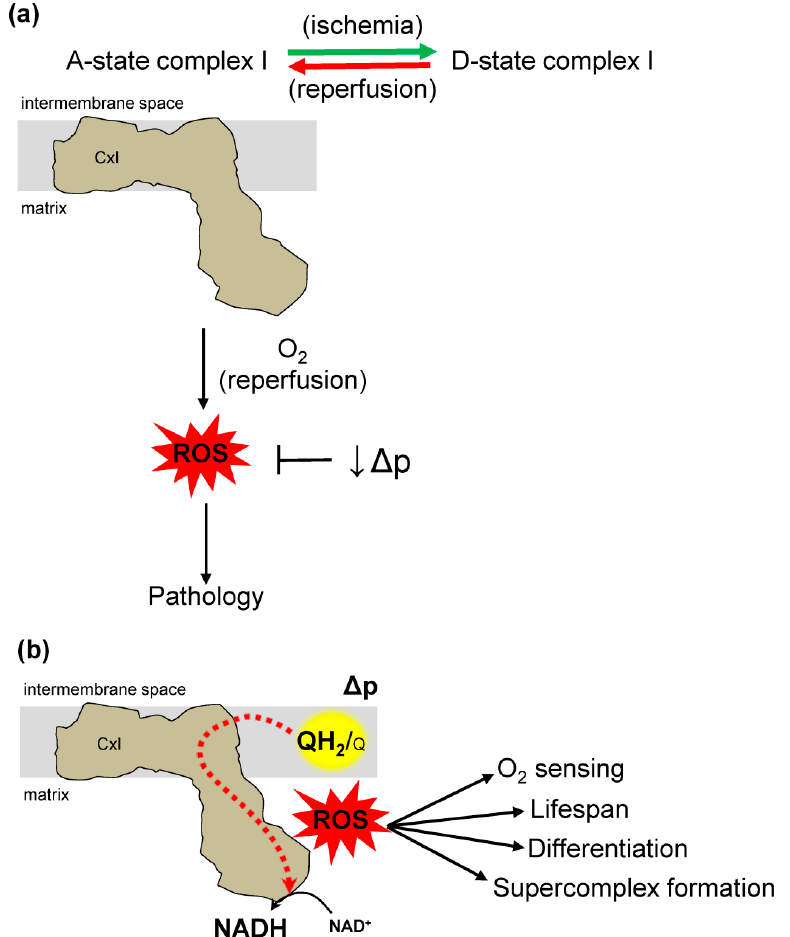
Figure 4. Dual role of complex I reverse electron transfer in pathology and physiology. ( a ) Complex I (CxI) reverse electron transfer (RET) in pathology. Factors that a ff ect RET in ischemia reperfusion (IR) injury. During ischemia, succinate accumulation drives RET at complex II forcing electrons to complex I, where ROS is subsequently overproduced. Complex I has two states, active (A) and dormant (D). Ischemia drives an A-form that transition to D-form. During reperfusion D-form transition back to A-form generating reactive oxygen species (ROS) that causes IR injury. The mitochondrial protonmotive force ( ∆ p) is a main driving force for RET. Therefore, decreasing the ∆ p removes a main driver of RET and ROS production at reperfusion. ( b ) Complex I reverse electron transfer contributes to diverse physiologic processes. The site-specific ROS production has a role in oxygen (O 2 ) sensing, lifespan extension, cell di ff erentiation, and supercomplex